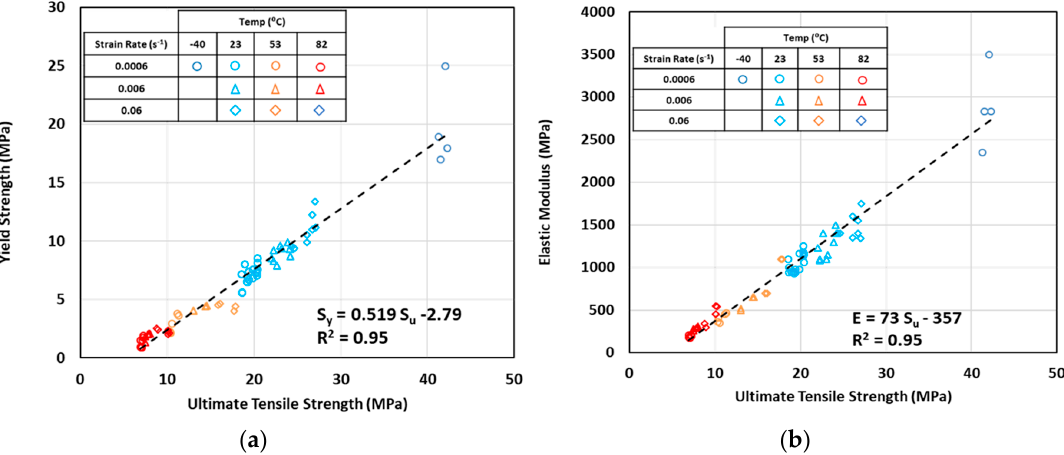
Figure 8. Correlations between yield strength ( a ) and elastic modulus ( b ) as linear functions of ultimate tensile strength for all temperatures and strain rates.